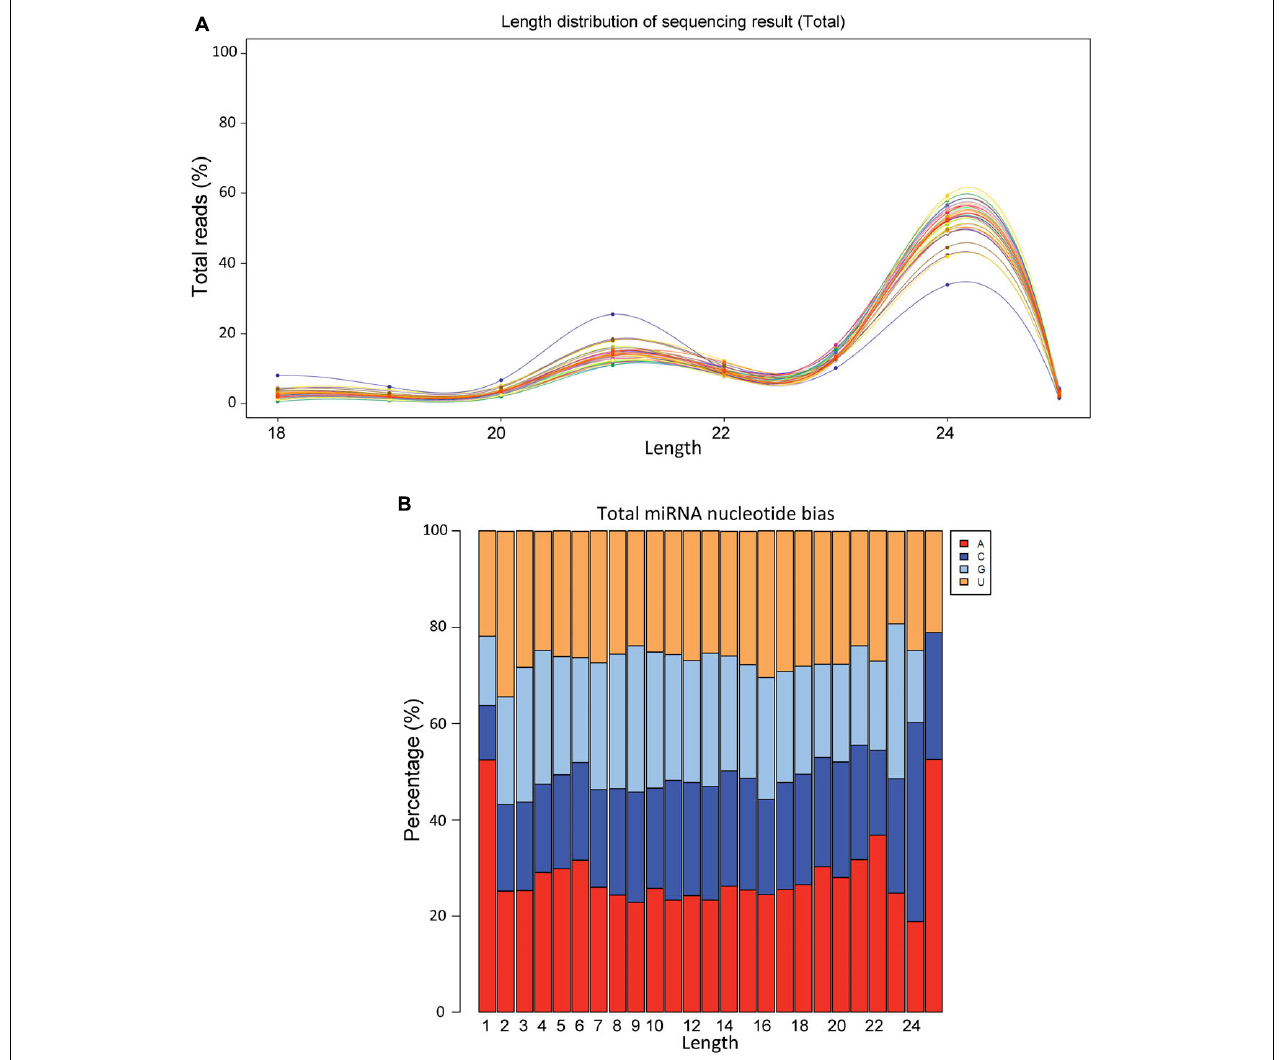
FIGURE 1 | Size distribution and nucleotide bias of miRNAs derived from sugar beet leaves. (A) Size distribution and (B) nucleotide bias.